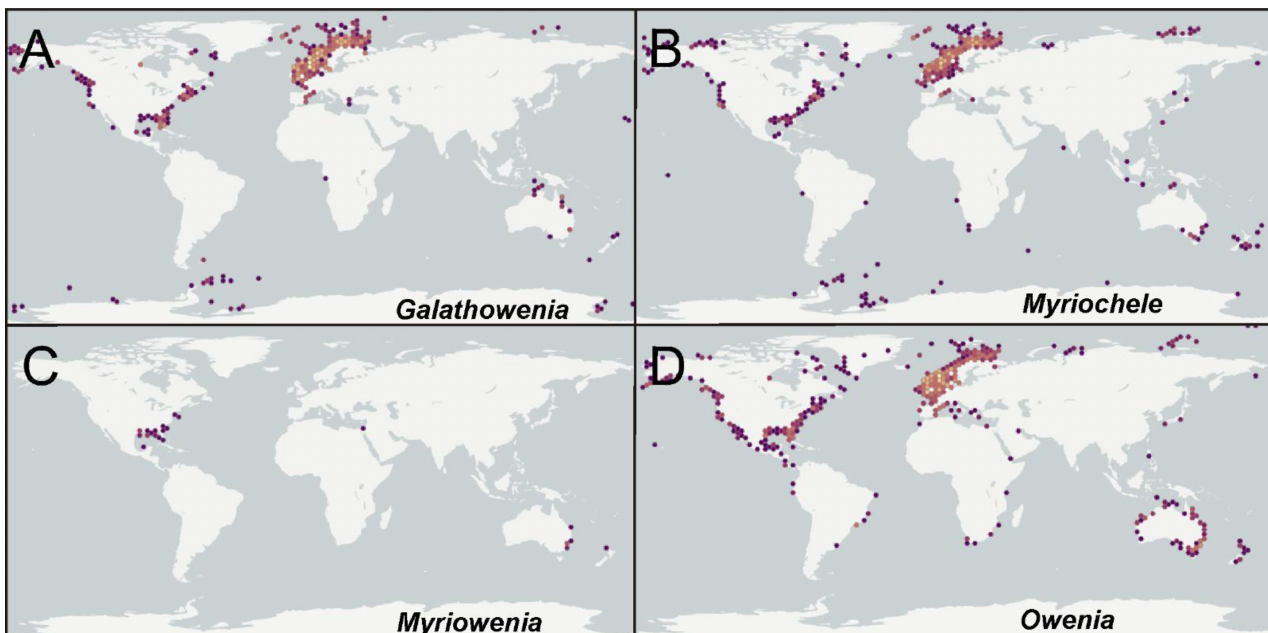
Figure 23. World distribution of all oweniid genera. ( A ) Galathowenia ; ( B ) Myriochele ; ( C ) Myriowenia ; ( D ) Owenia . Source: GBIF [118]